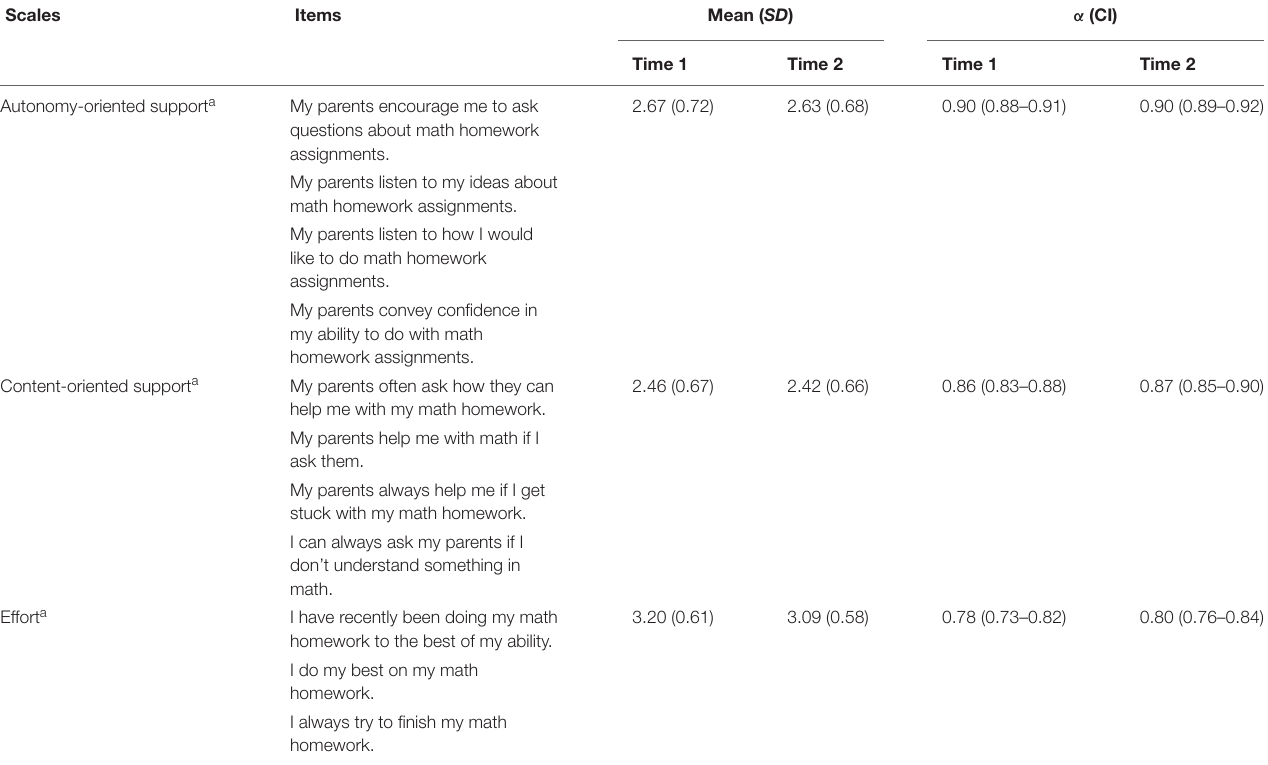
TABLE 1 | Autonomy-oriented support, content-oriented support, and effort items. Scales